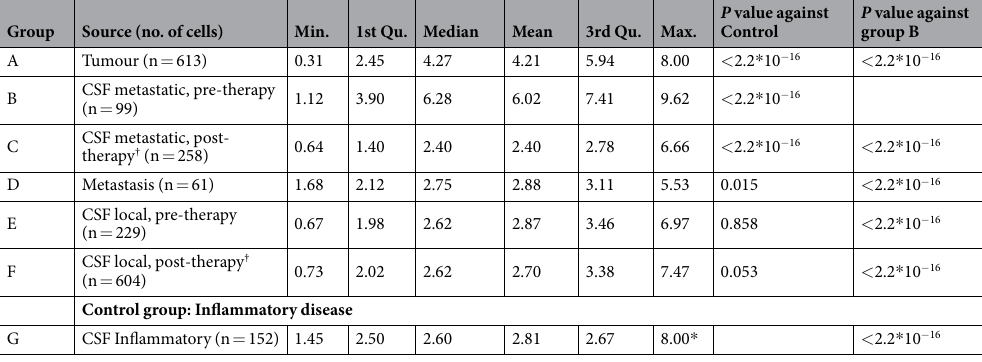
Table 3. Statistical data (after normalization) of the distribution of fluorescence lifetime (ns) in each source group. Slides were combined as a group according to the source (tumour/CSF/metastasis), spread at diagnosis (localised/metastatic) and stage of therapy (pre-therapy/post-therapy † ). Control group contains slides from patient with inflammatory disease. We used Wilcoxon signed rank test to compared control group against every single group separately ( P value against control group). We also compared every single group against the CSF metastatic, pre-therapy group ( P value against group B). * One cell. † During and after chemo/radiotherapy. ATRT, atypical teratoid/rhabdoid tumour, CSF, cerebrospinal